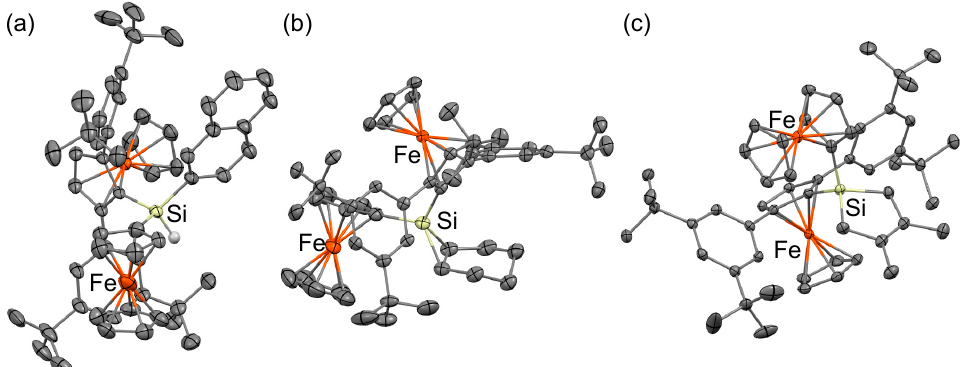
Figure 1. Molecular structures of ( a ) 5 , ( b ) 9a , and ( c ) 14 with thermal ellipsoids at 50% probability; hydrogen atoms other than that of the Si-H moiety are omitted for clarity.